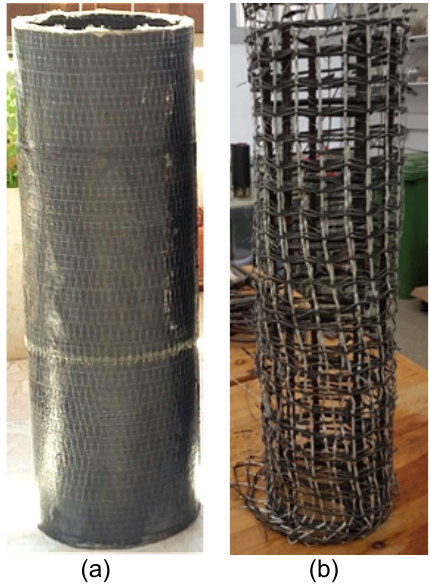
Figure 2. ( a ) Stay-in-place FRP tube form; ( b ) textile fiber wrapped externally around the reinforcement